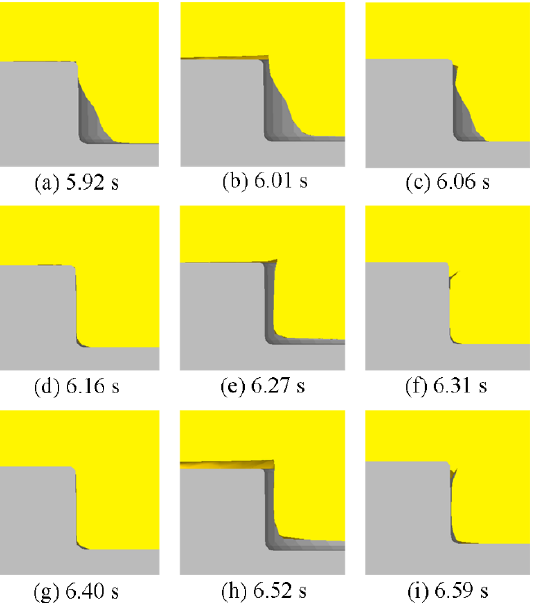
Figure 13. Formation of fold defect at root of boss: ( a ) t = 5.92 s, ( b ) t = 6.01 s, ( c ) t = 6.06 s, ( d ) t = 6.16 s, ( e ) t = 6.27 s, ( f ) t = 6.31 s, ( g ) t = 6.40 s, ( h ) t = 6.52 s, and ( i ) t = 6.59 s.